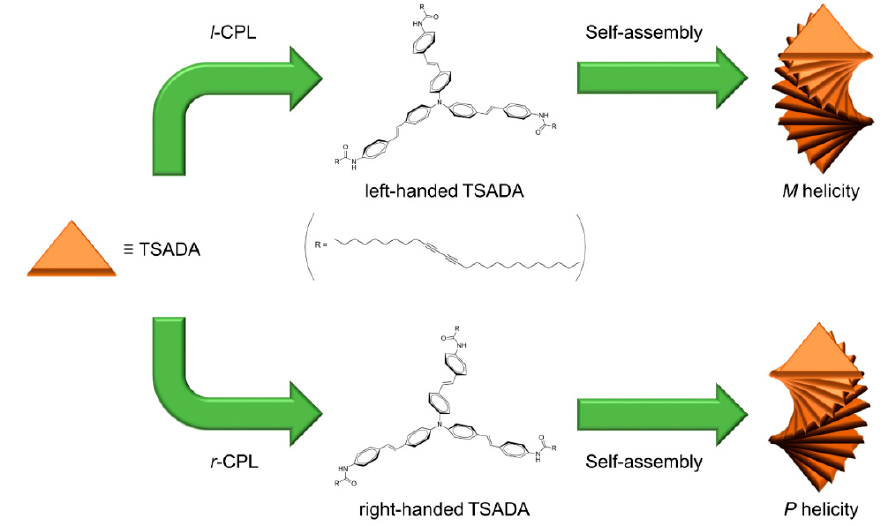
Figure 3. Supramolecular chirality of the thin film of TSADA obtained by self-assembly and solution casting of the benzene solution (1 mg/mL). ( a ) CD spectra with control of the rotational direction of the self-assembled structures by irradiation of l -CPL (circularly polarized light) (black line) or r -CPL (red line) during self-assembly and solution casting. ( b ) The g CD values of the supramolecular thin film of TSADA without control (blue dots) or with control of the rotational direction by using l -CPL (black dots) or r -CPL (red dots). The measurements were performed at the center and four edges of the substrates to cover all areas of the supramolecular thin film.